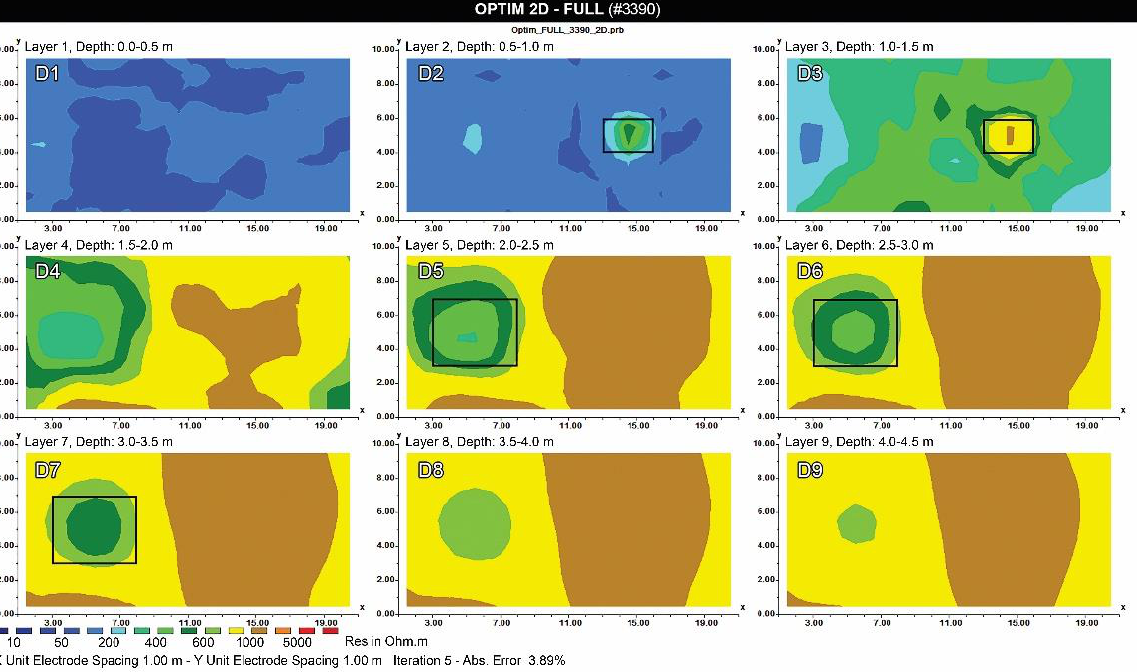
Figure 7. Inversion results from optimum array produced by 2D algorithm.